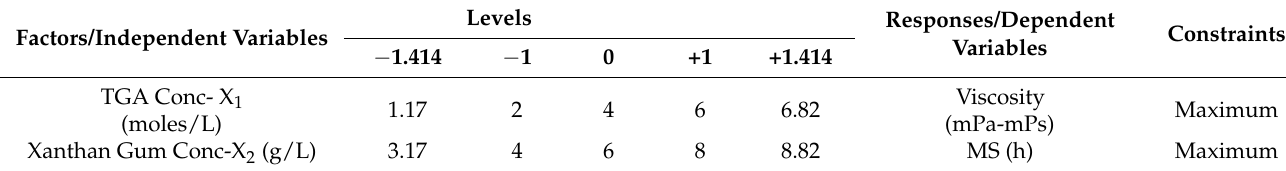
Constraints Variables